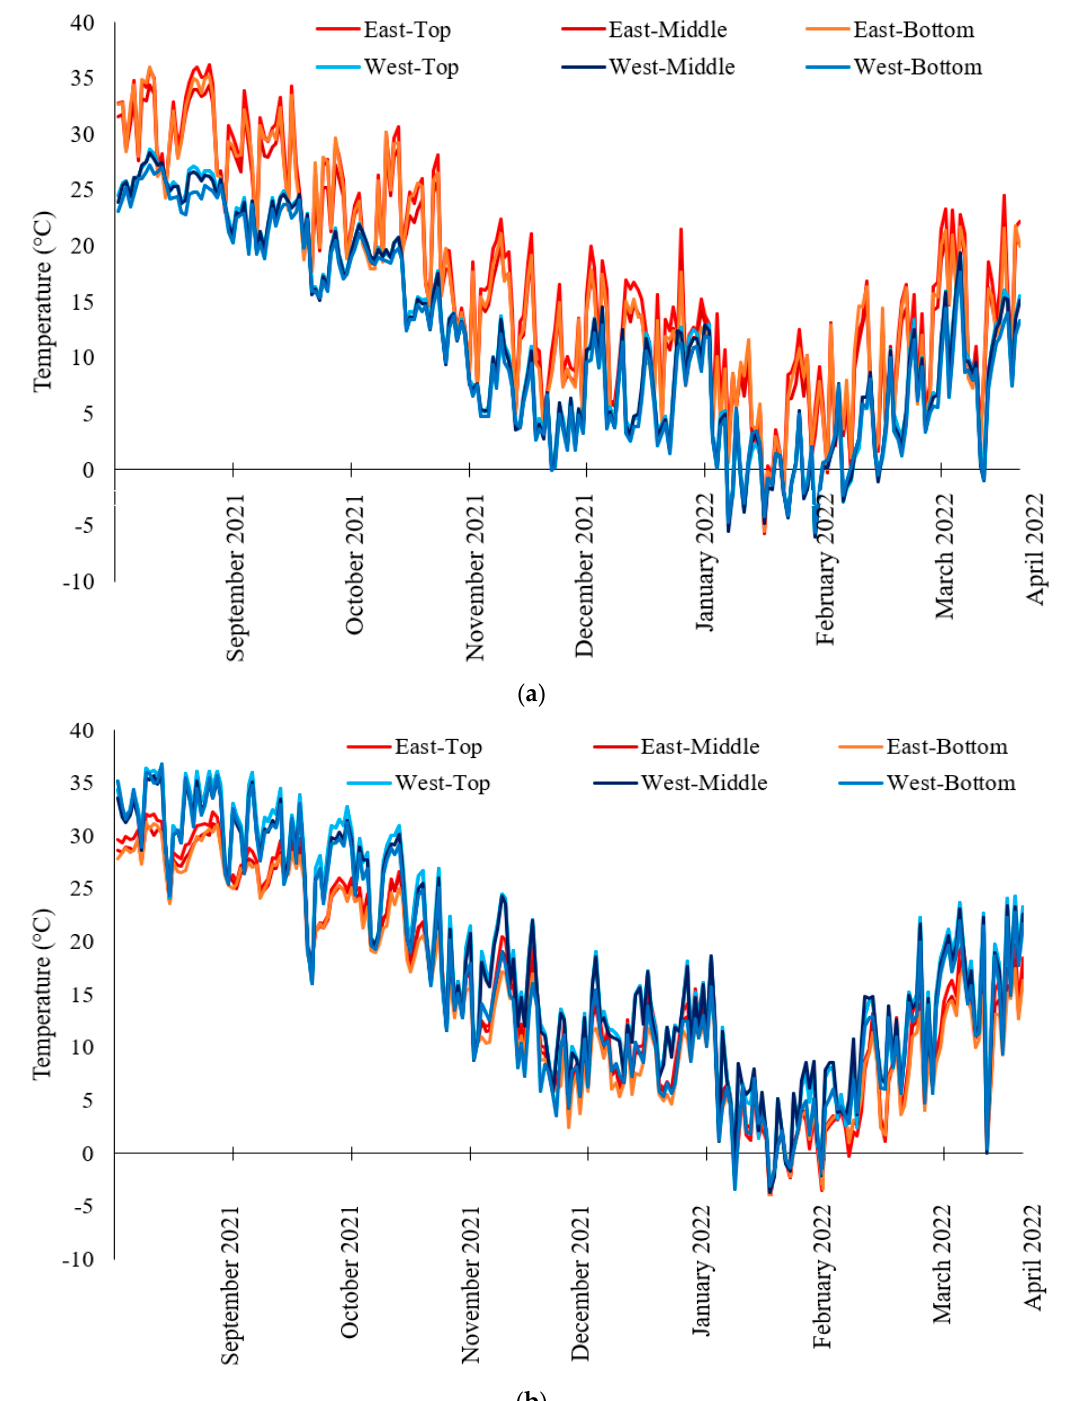
Figure 4. Temperature change on the tank wall at three different elevations of the top, middle, and bottom from two different sides of east and west measured via attached thermocouples: ( a ) at 10:30 a.m. and ( b ) at 4:30 p.m.